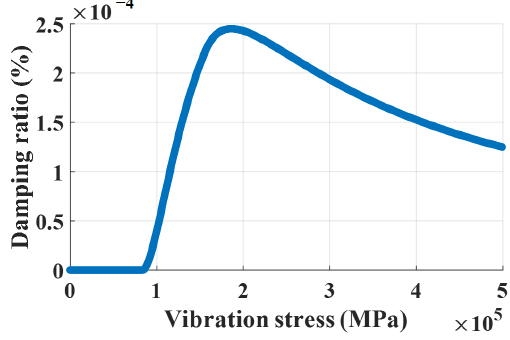
Figure 17. DCC of ring for the blisk (3 ND first Bend).